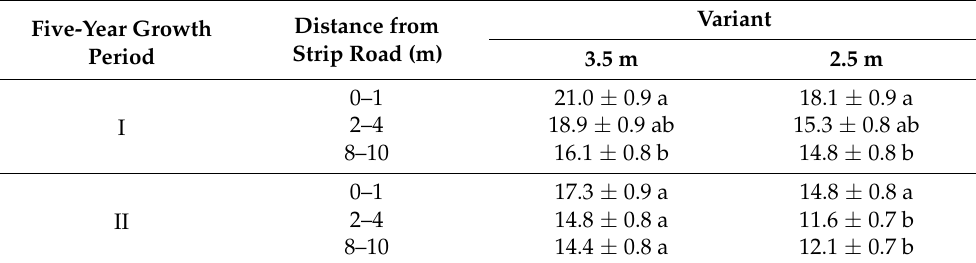
Table 3. Five-year growth in diameter (mm) of the whole tree (Mean values ± SE) related to the distance from the strip